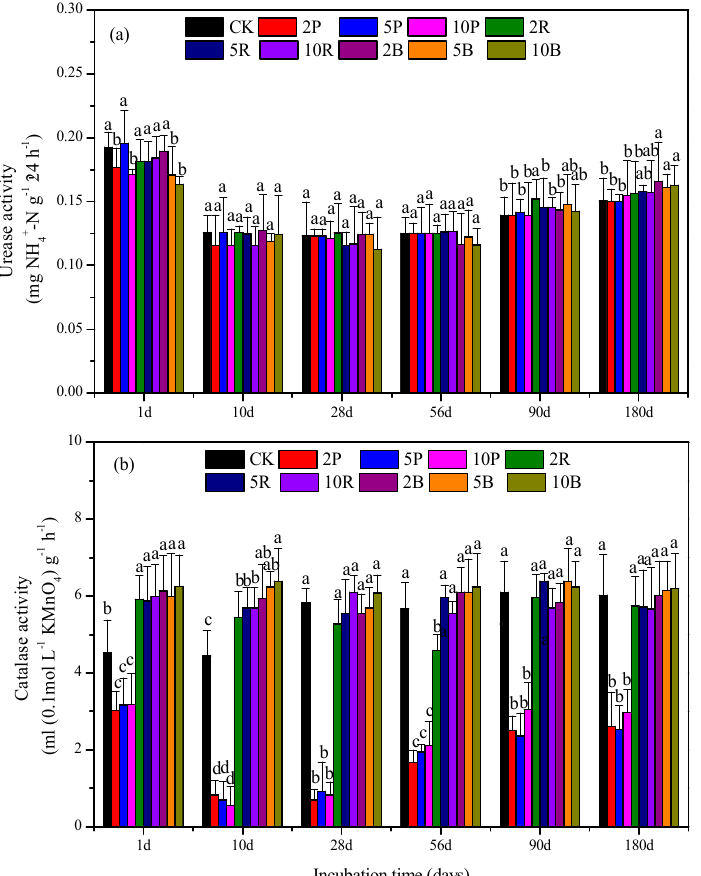
Figure 4. Changes in the activities of urease ( a ) and catalase ( b ) over 180 days with phosphate, red mud, and biochar (CK: control; 2P: 2% phosphate; 5P: 5% phosphate; 10P: 10% phosphate; 2R: 2% red mud; 5R: 5% red mud; 10R: 10% red mud; 2B: 2% biochar; 5B: 5% biochar; 10B: 10% biochar). Error bars represent ± standard error. Lowercase letters above the error bars indicate significant differences among different treatments at the p < 0.05 level.